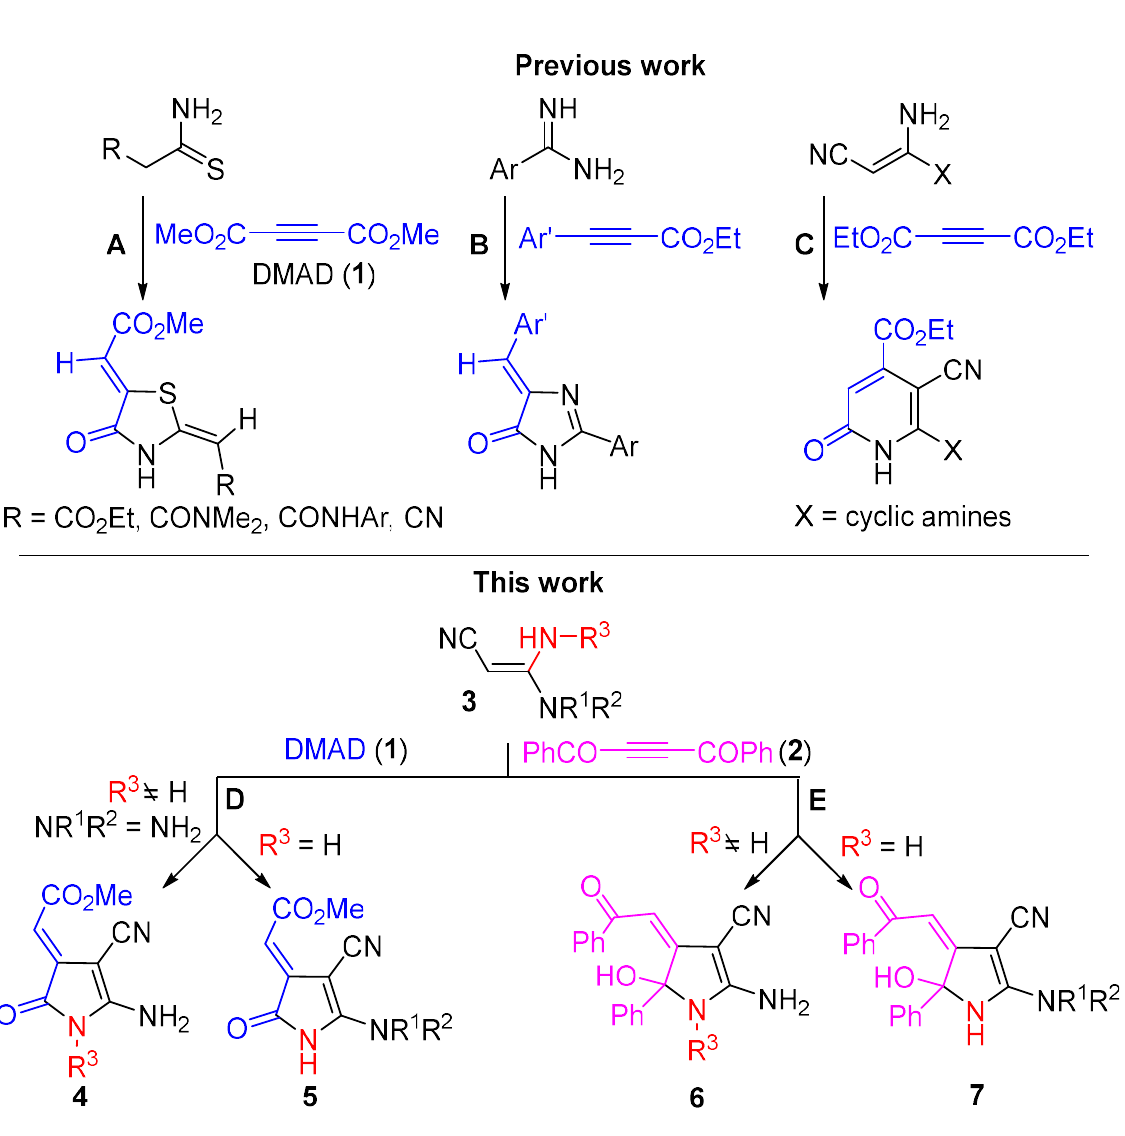
Scheme 1. Reaction of Carbonyl Derivatives of Acetylene with Thiocarbamoyl- and